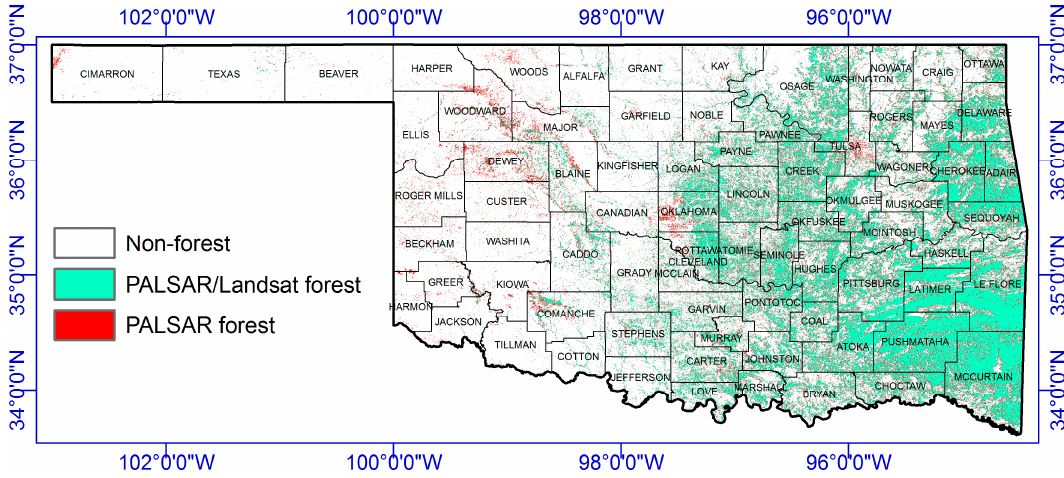
Figure 6. The spatial distribution of PALSAR-forest and PALSAR/Landsat-forest maps in 2010. Table 2. The confusion matrix of PALSAR/Landsat forest map in 2010 using random ground samples.